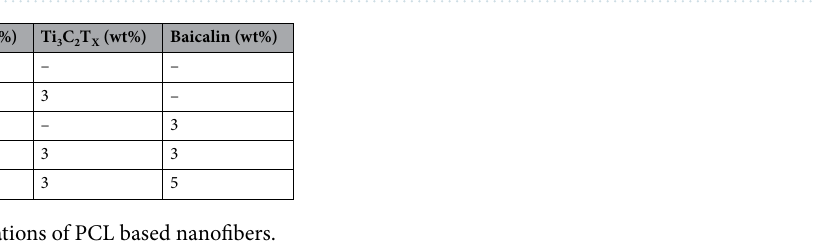
Figure 1. Preparation route of PCL based nanofibers. (Adobe Illustrator CS5, Version 15.0.0, https:// www. adobe. com/ produ cts/ illus trator. html).